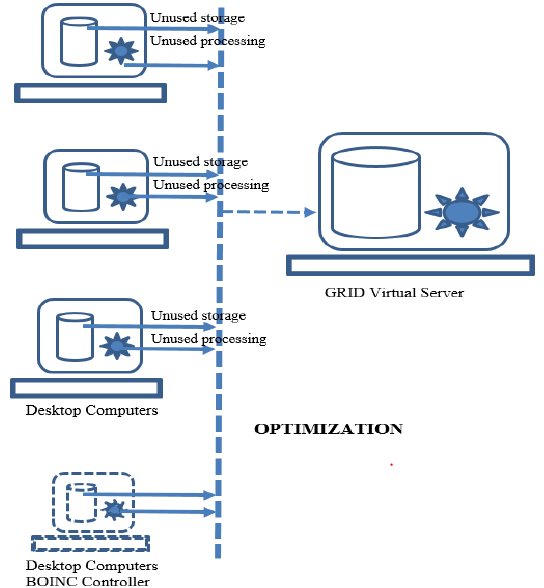
Figure 6. Optimized Grid Connectivity Using BOINC .